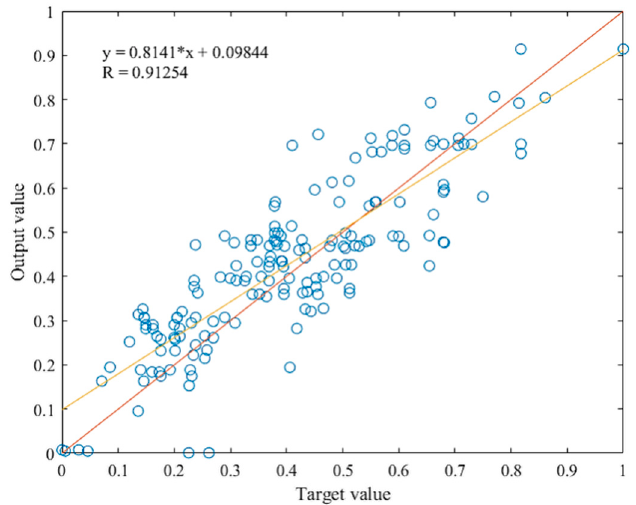
Figure 6. Relationship between target and output value after testing.